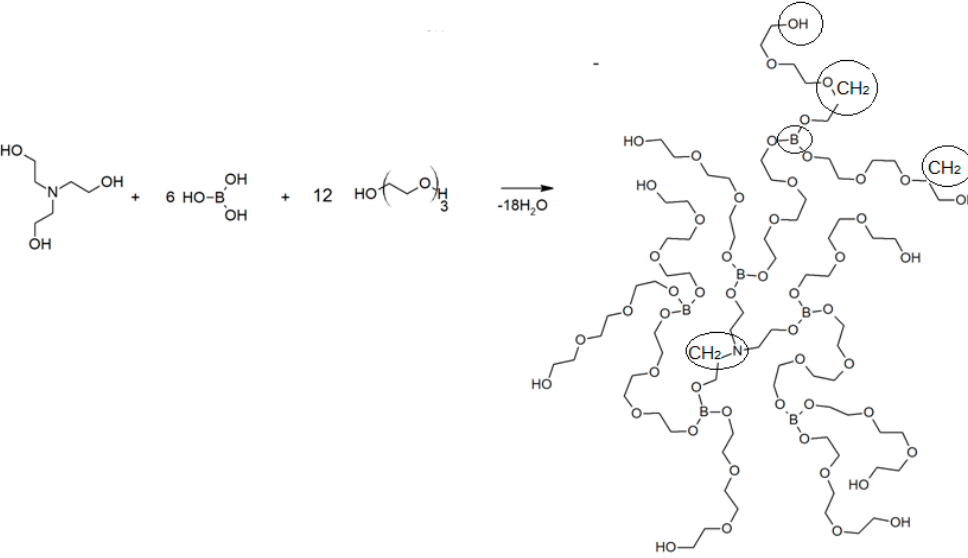
Figure 1. Scheme of synthesis of aminoethers of boric acid based on triethylene glycol AEBA-TEG.